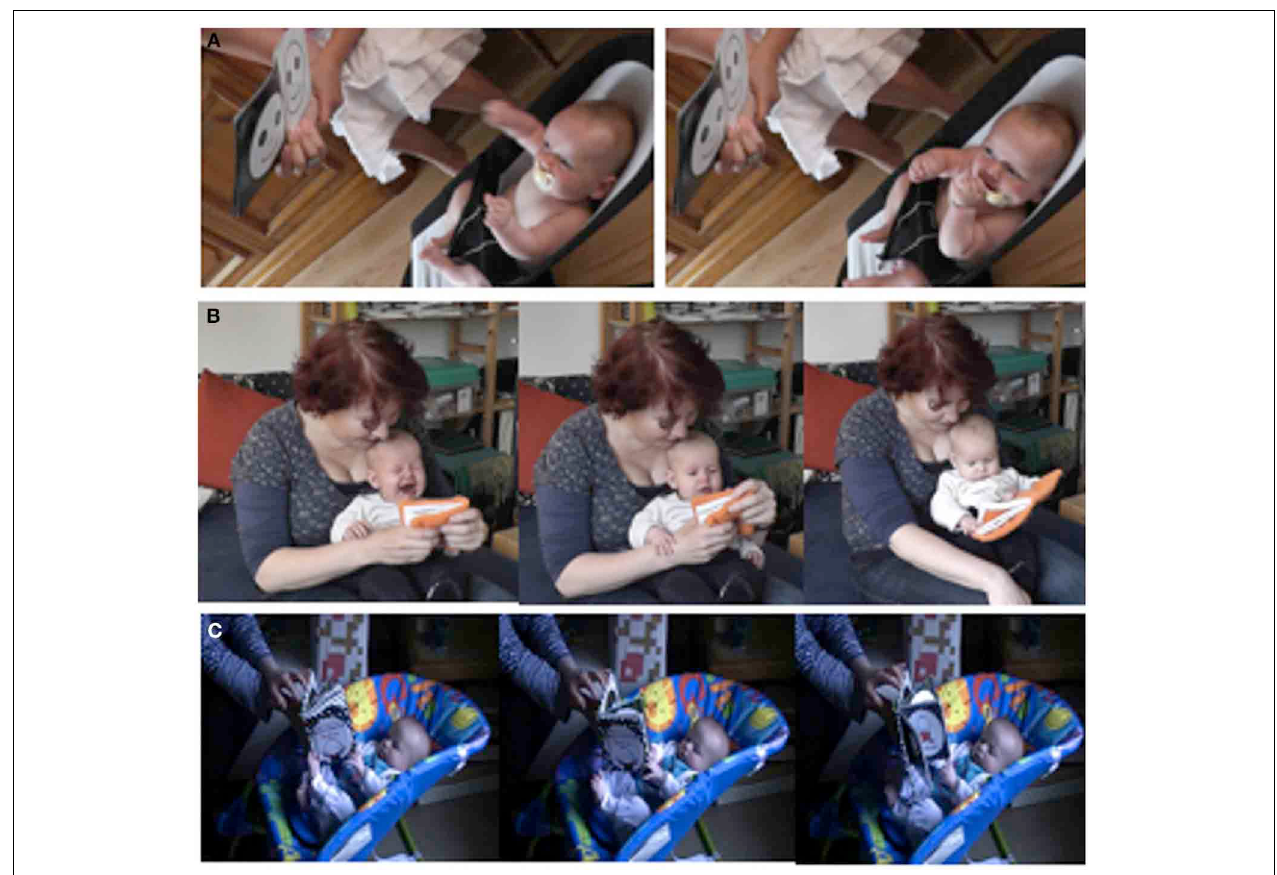
FIGURE 2 | Three examples of book sharing with books specifically designed for young infants. (A) Visually engaging a 3-month-old with high contrast patterns. (B) Soothing a 3-month-old with crinkly pages. (C) Scaffolding a 3.5-month-old’s motor skills with rigid pages.